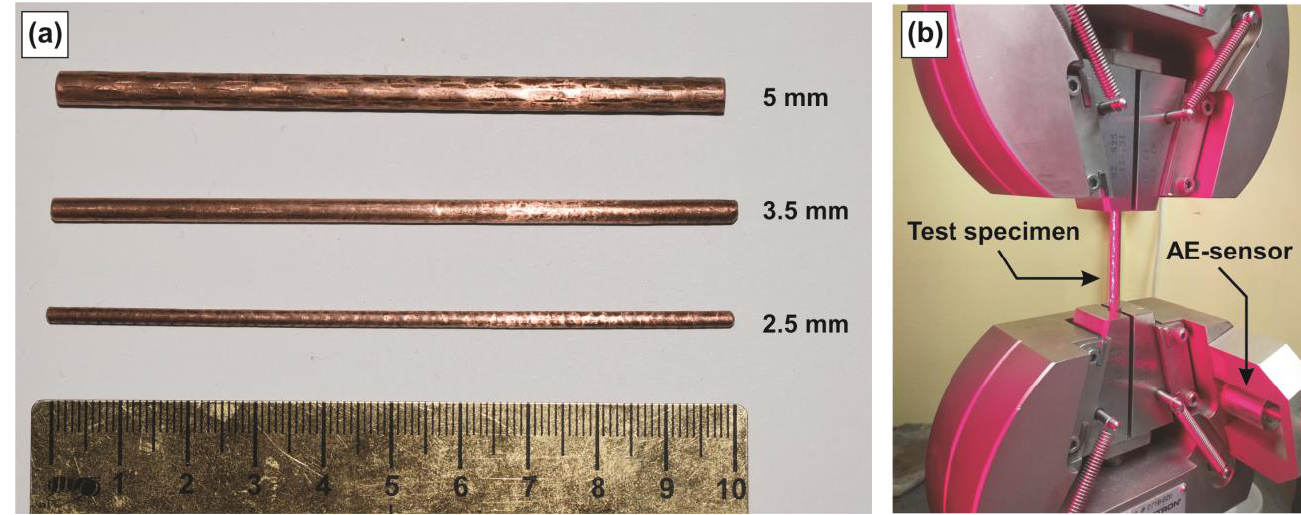
Figure 1. ( a ) The appearance of the tensile test specimens with different diameters and ( b ) the test installation.